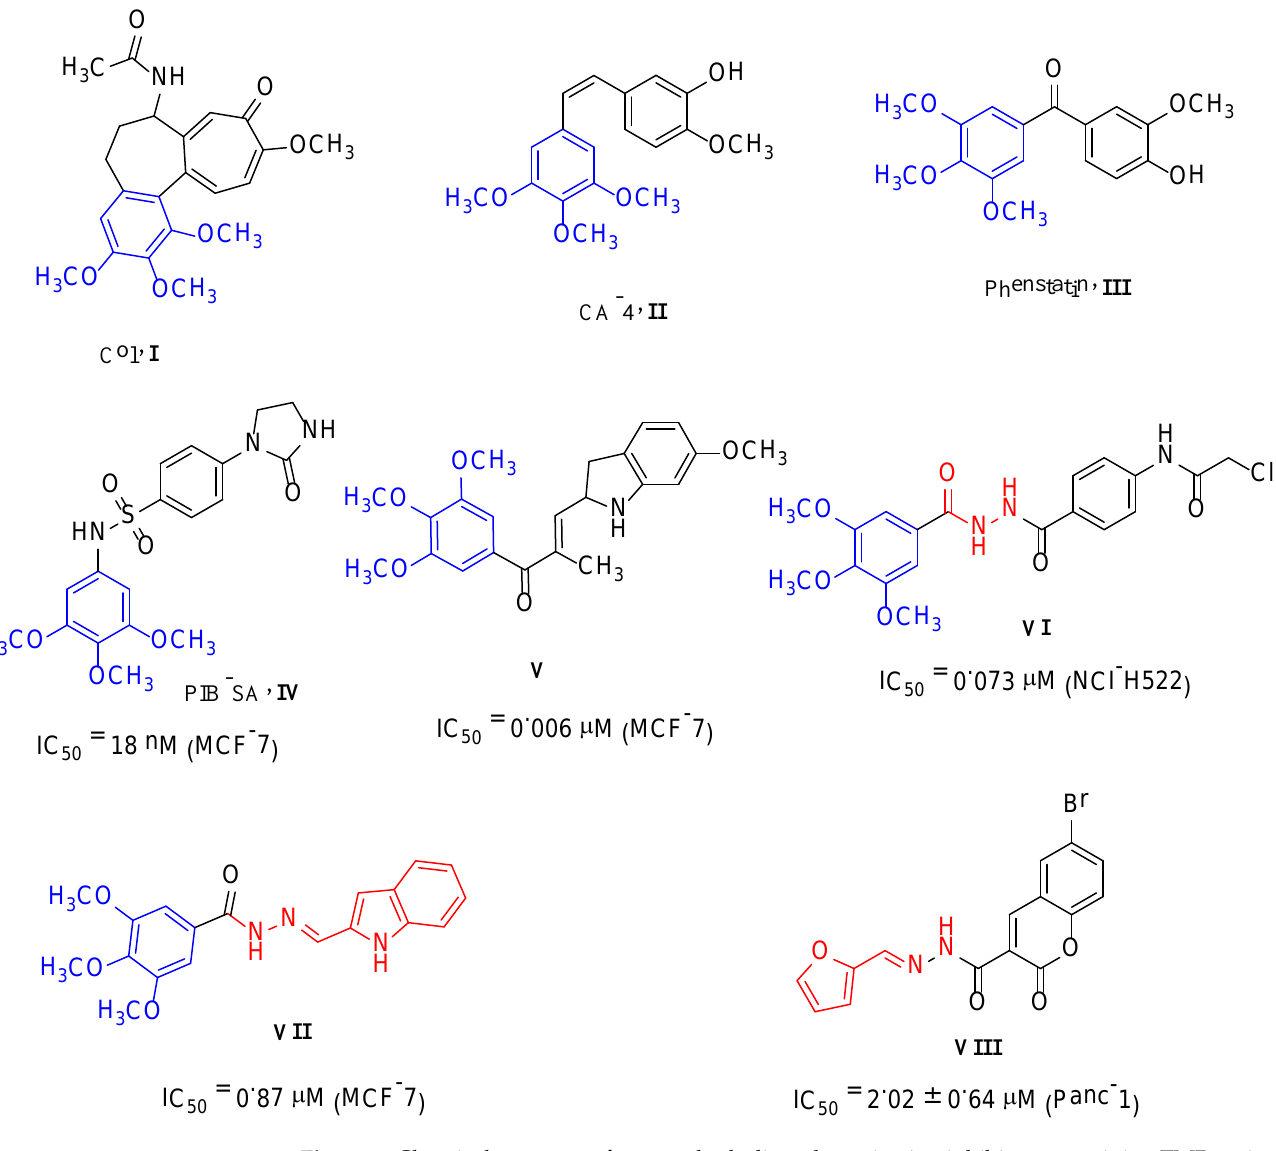
Figure 1. Chemical structure of reported tubulin polymerization inhibitors containing TMP moiety ( I – VI ) and reported Schiff base derivatives ( VII – VIII ) possessing anticancer activity.